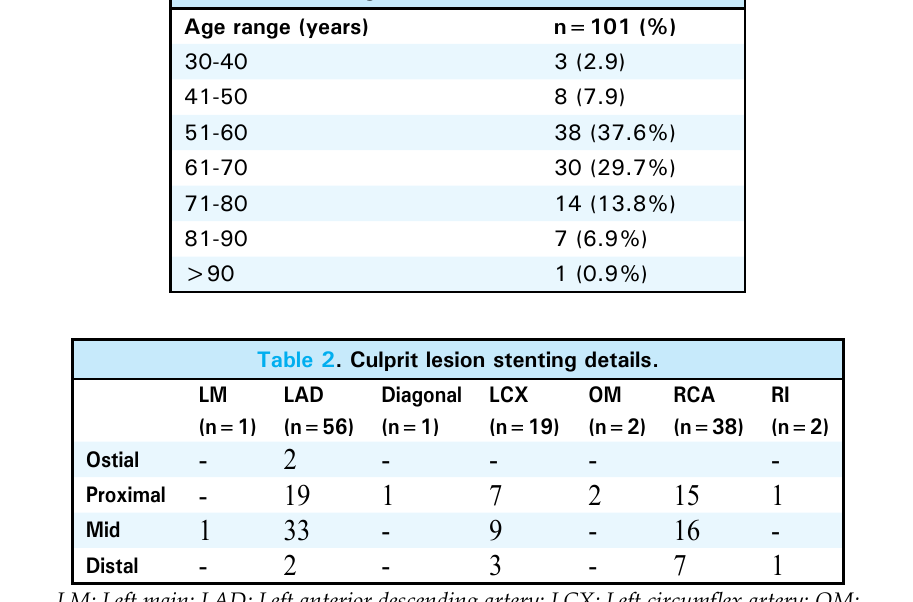
Table1. Age distribution of the cases.